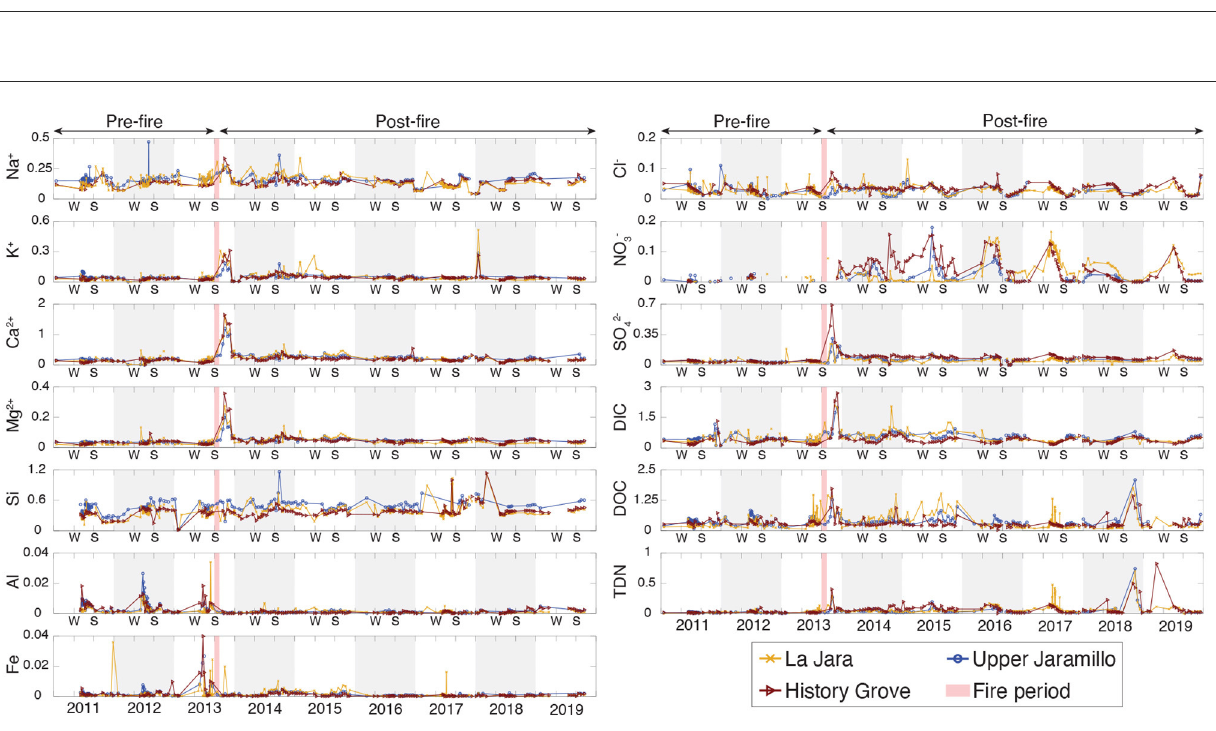
FIGURE4 Pre- and post-fire concentrations in [mmol L − 1 ] of major cations (Na + , K + , Ca 2 + , and Mg 2 + ), Si, polyvalent cations Fe and Al, strong anions (Cl − , NO − 3 , SO 2 − 4 ), dissolved inorganic and organic, and total dissolved nitrogen of La Jara, History Grove and Upper Jaramillo surface waters. The shaded red region marks the timing of the Thompson Ridge Wildfire from May 31 through June 30,